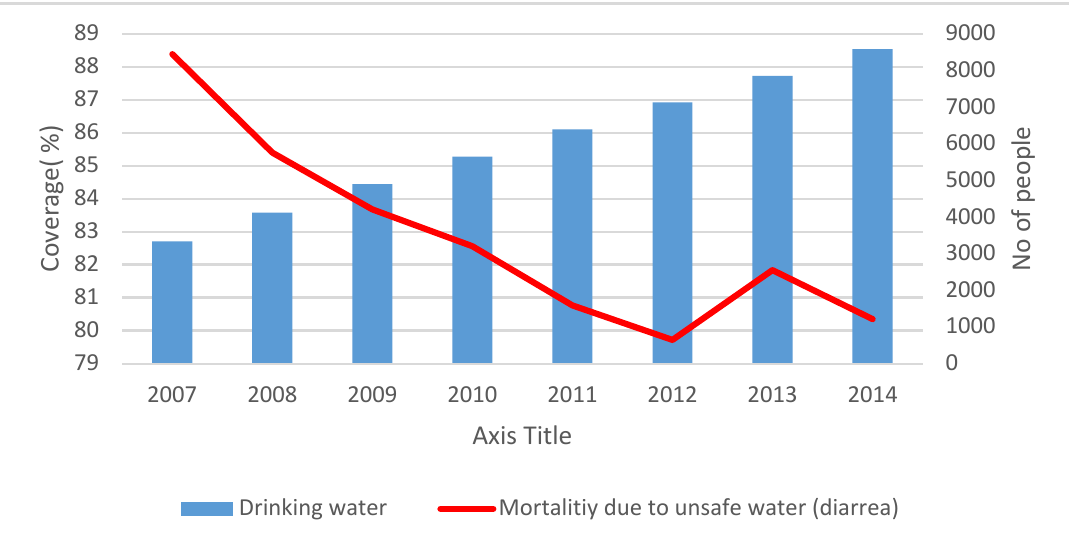
Figure 3. Graph of indicators 3.9.2 and 6.1.1 in Indonesia (Sources: statistic data from JMP and BPS).